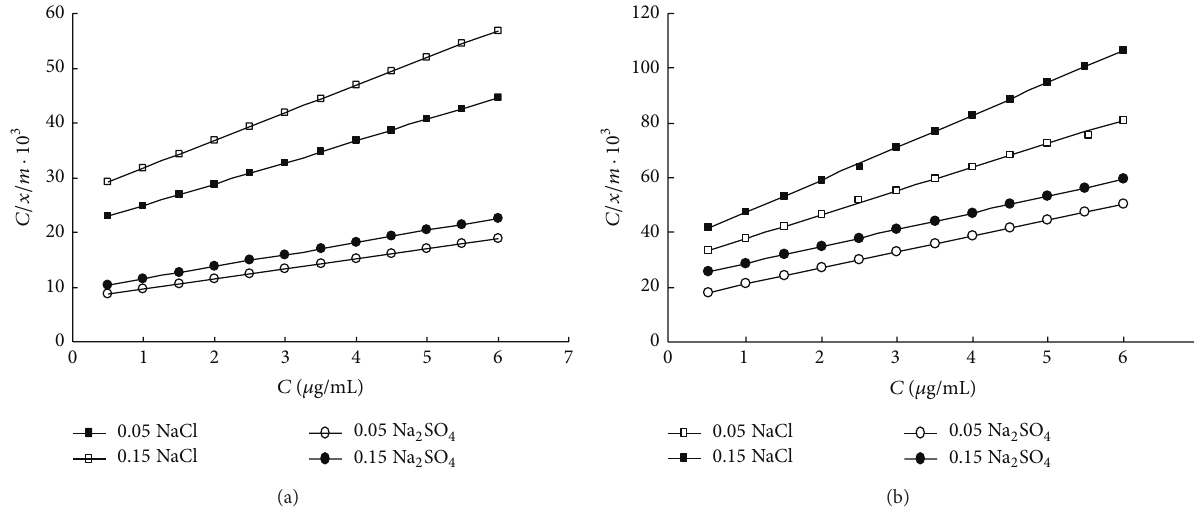
Figure 2: Langmuir isotherm adsorption of (a) alluvial soil and (b) calcareous soil, toward Cd 2+ , at different concentrations of NaCl and Na 2 SO 4 as electrolyte